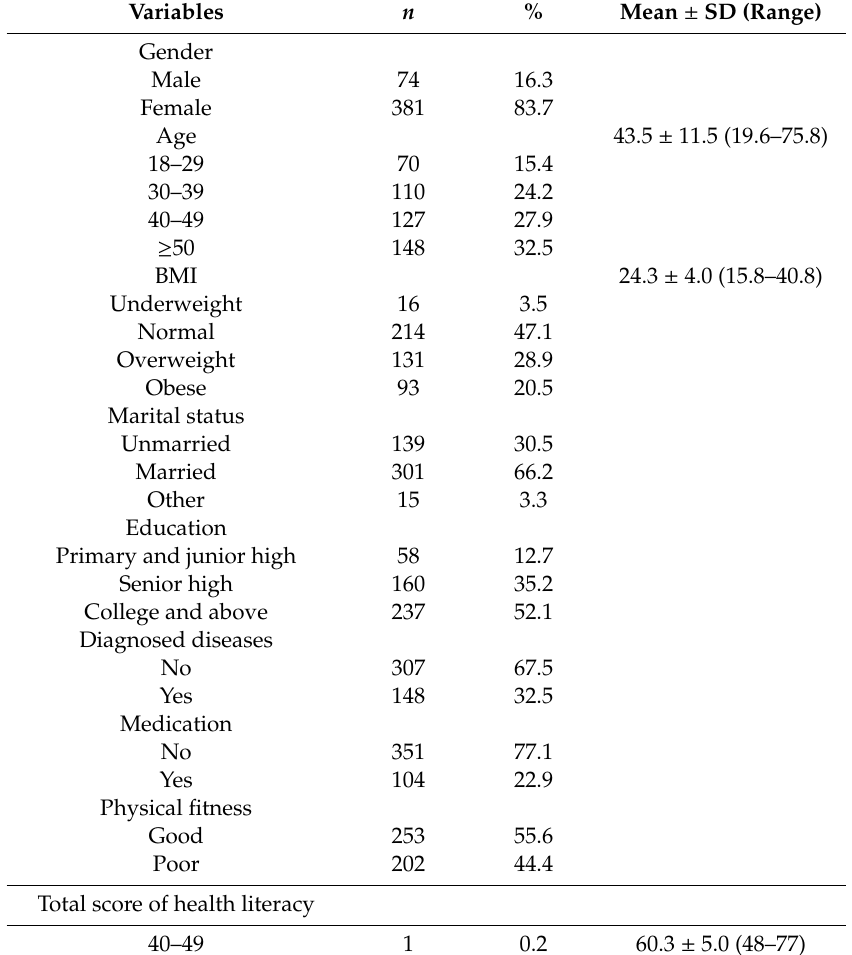
Table 2. Characteristics of the respondents and total score of health